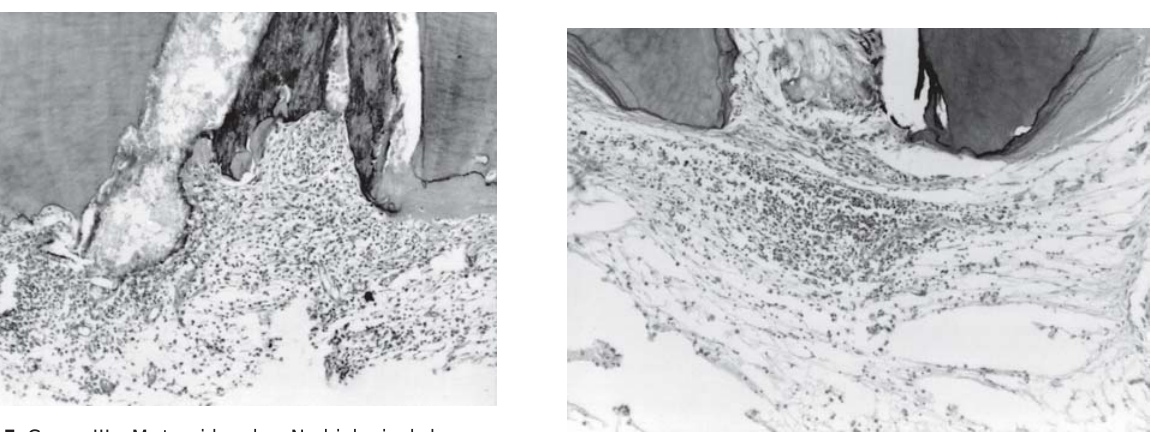
FIGURE 7- Group IV - Calcium hydroxide + Metronidazole – No biological closure and periodontal ligament showing a intense chronic inflammatory infiltrate. H. E., 100X